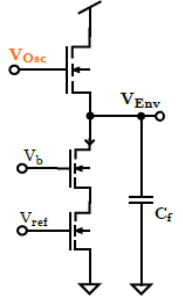
Figure 7. Implementation of the envelope detector.